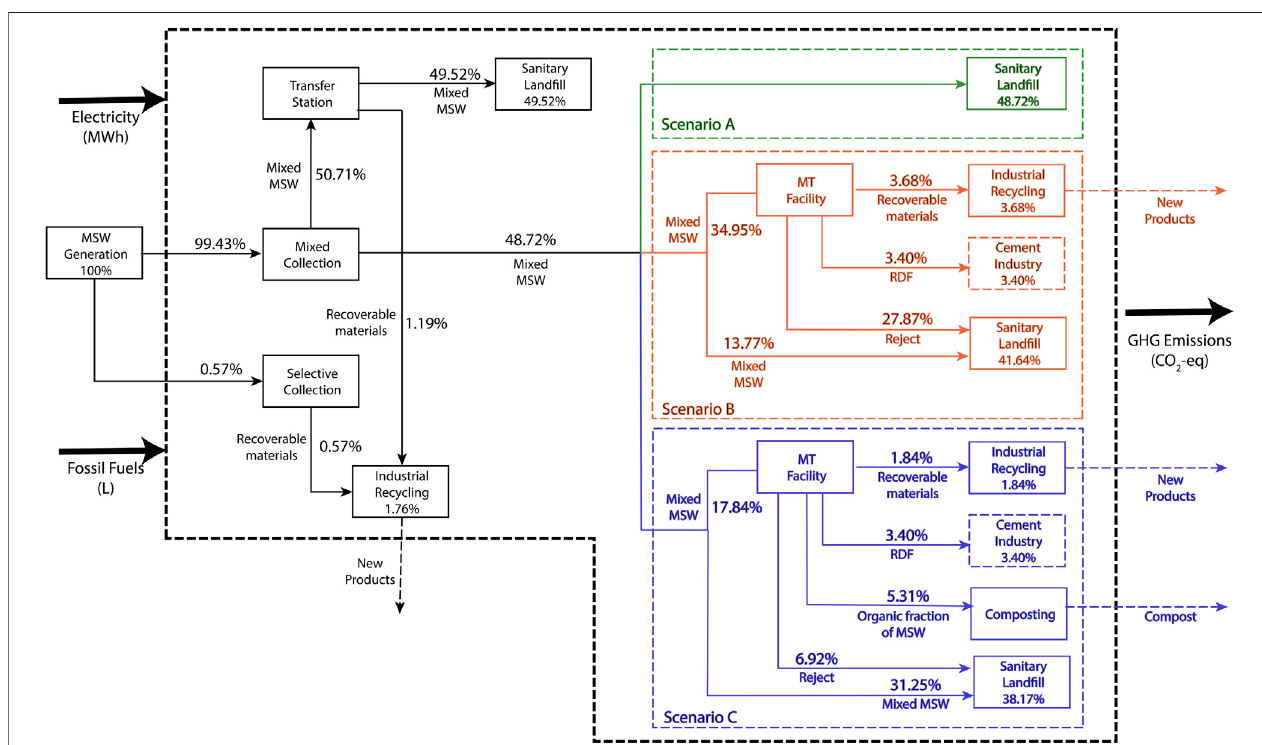
FIGURE 2 | Current and proposed MSW management scenarios and system ’ s